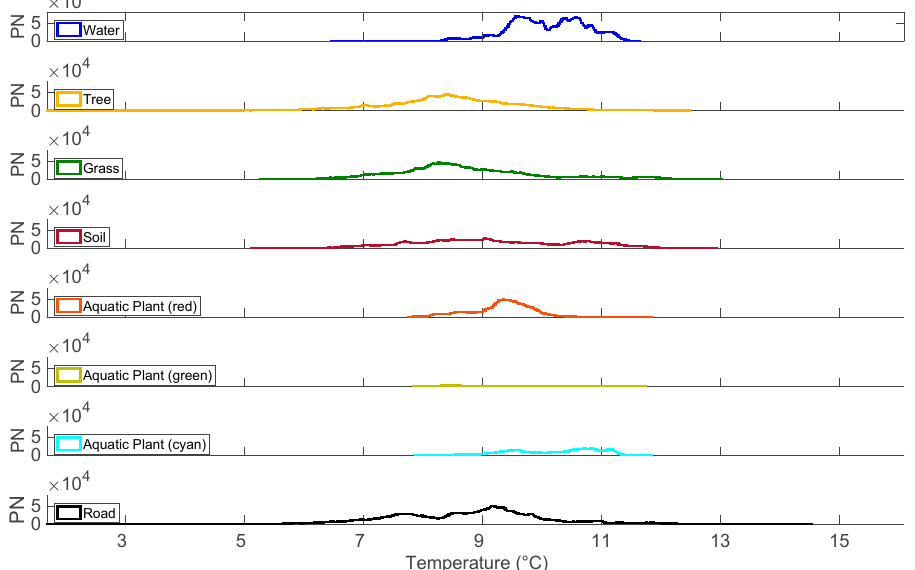
Figure 10. The temperature histograms of the clusters showing in Figure 9. PN is the pixel number. Here, clusters “Green Tree” and “Yellow Tree” have been merged into one cluster called “Tree”.